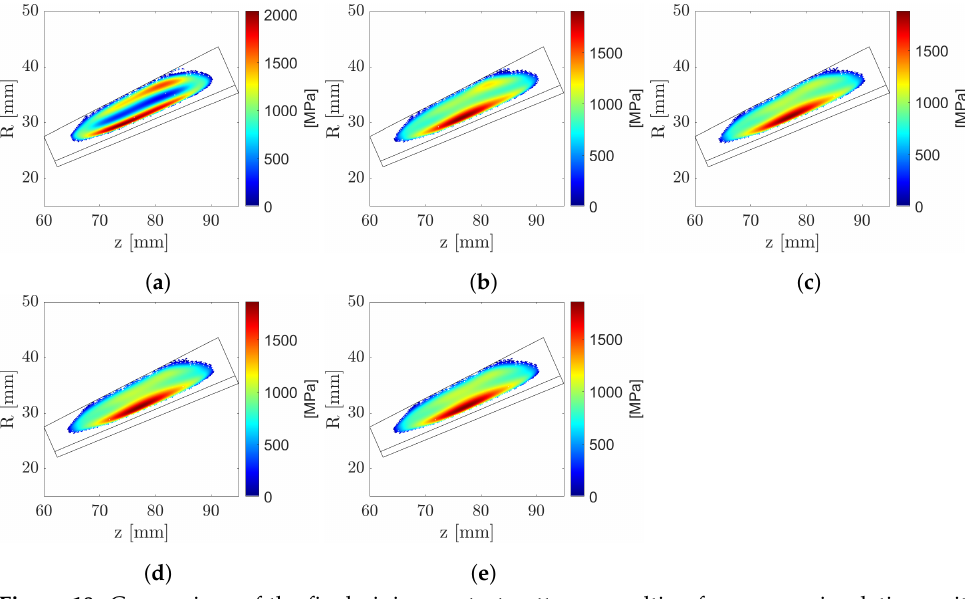
Figure 18. Comparison of the final pinion contact patterns resulting from wear simulations with different numbers of geometry updates. ( a ) Update after 30 Mc. ( b ) Update every 10 Mc. ( c ) Update every 5 Mc. ( d ) Update every 1 Mc. ( e ) Update every 0.5